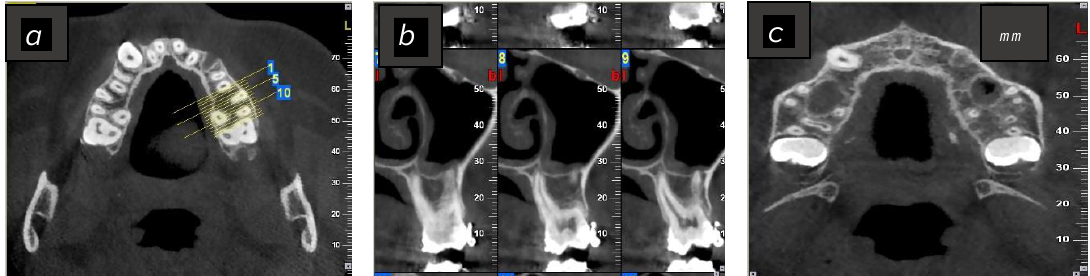
Figure 1. Representative cone beam computed tomography (CBCT) images showing the palatal root apex not in contact with the sinus floor (MSF). ( a , c ) A maxillary axial CBCT view; ( b ) a maxillary sagittal CBCT view.1; 5 and 10 are the slices numbers.